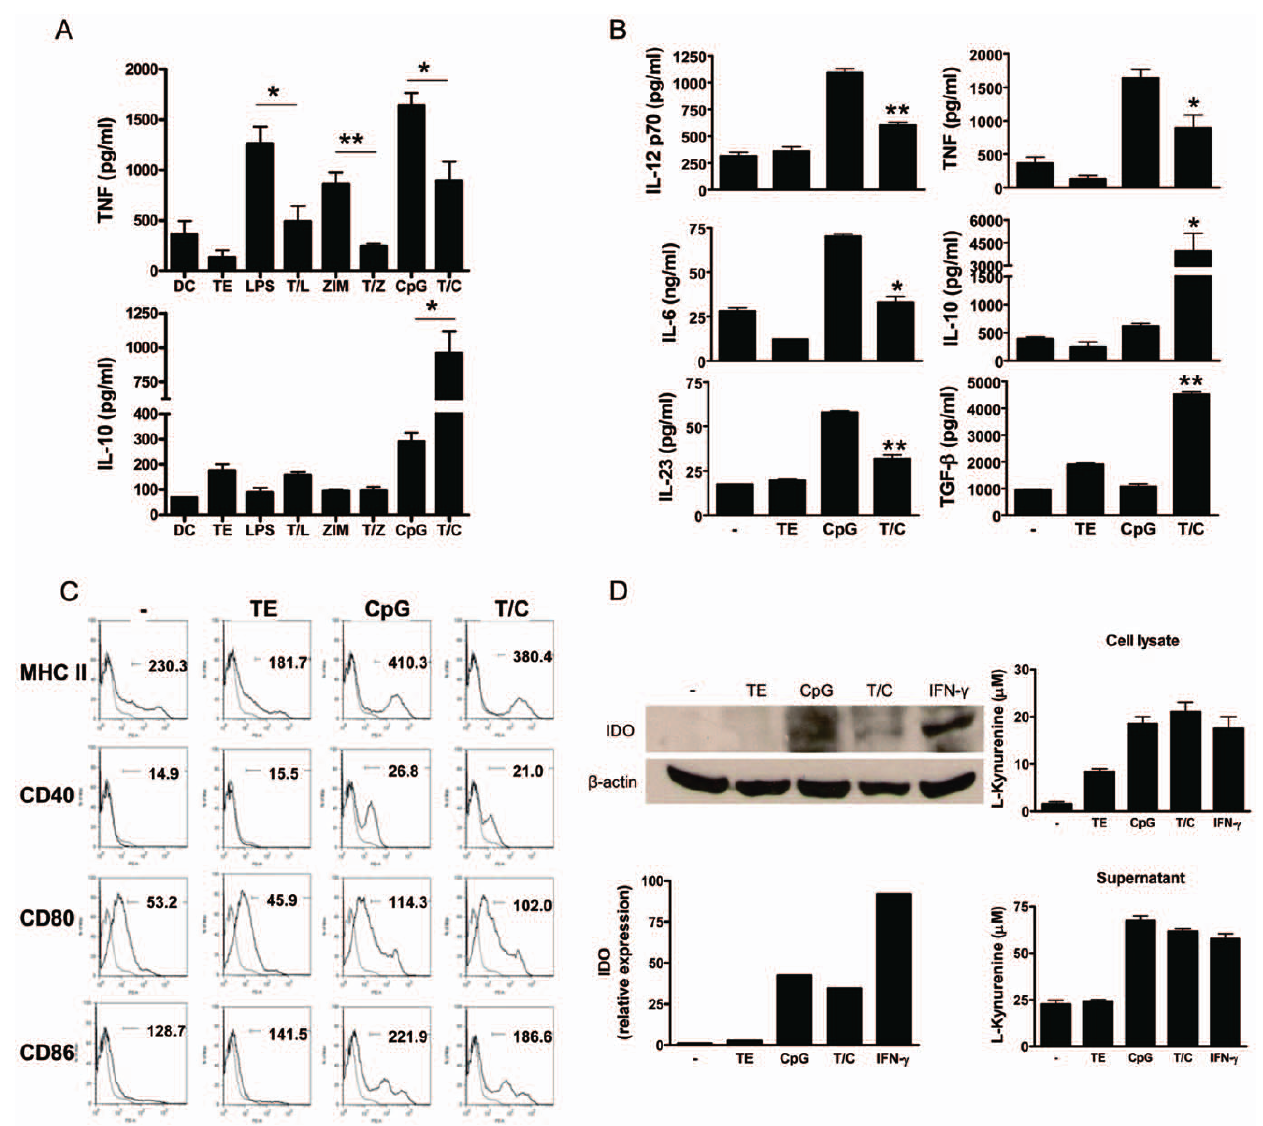
Figure 1. Cytokine production, phenotype and IDO expression by differentially-maturated DC. A) The DC were generated from DBA/1J mice and cultured for 18 h with LPS, Zymosan or CpG in presence or absence of TE. IL-10 and TNF were detected by ELISA. * P , 0.05, ** P , 0.005 B) DC were cultured for 18 h with medium, TE, CpG and T/C. Supernatants were tested for IL-12p70, TNF, IL-6, IL-10, IL-23, TGF- b by ELISA. * P , 0.05, ** P , 0.005 in IL-12p70, TNF, IL-6 and IL-23 versus CpG group, and * P , 0.05, ** P , 0.005 in IL-10 and TGF- b versus the rest of the groups. C) DC were stimulated as described above and the expression of MHCII and costimulatory molecules (thick lines) was performed by FACS gating the cells on the basis of CD11c + cells. Thin lines show isotype control and values represent the mean fluorescent intensity (MFI). D) Western blot analysis for IDO detection in whole lysates from DC treated as decribed above, using anti- b -actin Ab as the loading control. Data obtained were analyzed by scanning densitometry and were normalized according to the ratio IDO/ b -actin expression and these values were compared to medium treated-DC (left panels). L-kynurenine concentration (IDO activity), was determined by a colorimetric assay in lysates or supernatants (right panels) respectively from DC treated as described above. Data shown are representative of two (D) or three (A, B and C) independent experiments. Bars in A, B and D are the means 6 SD of triplicate wells per group.